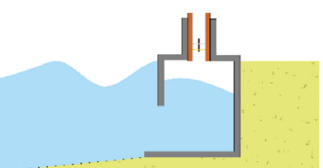
Figure 2. Schematic diagram of oscillating water column WEC.